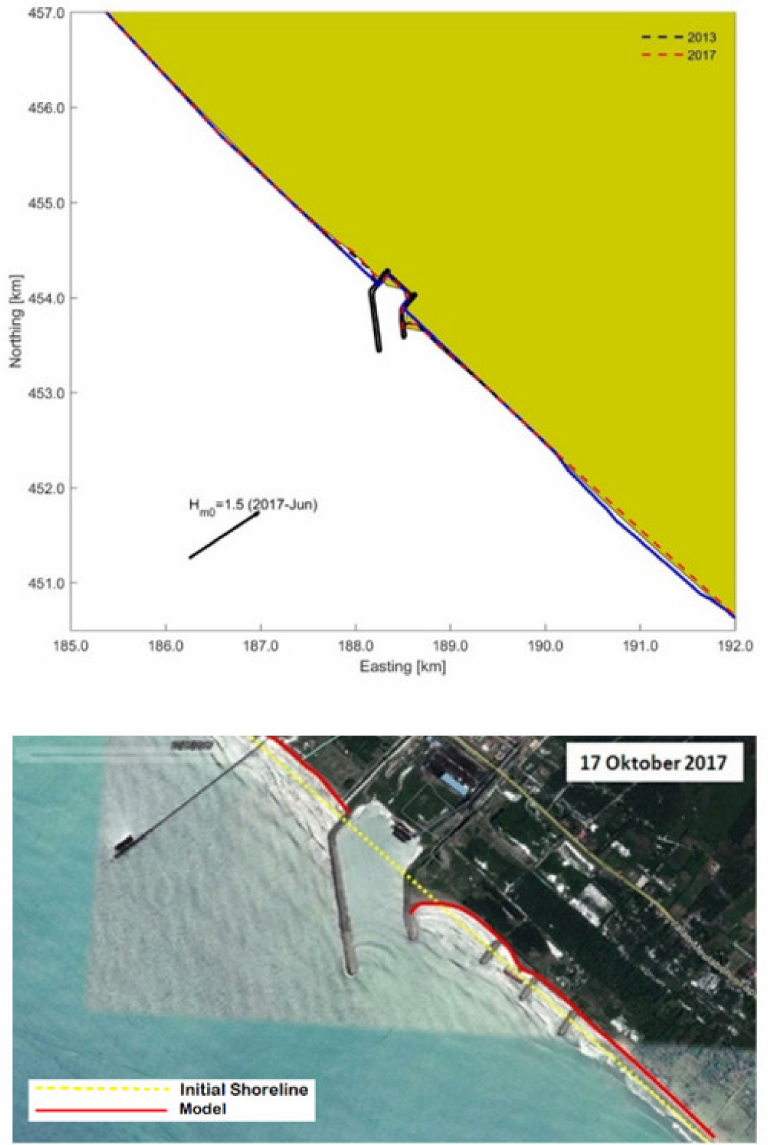
Figure 6. Coastline change simulation